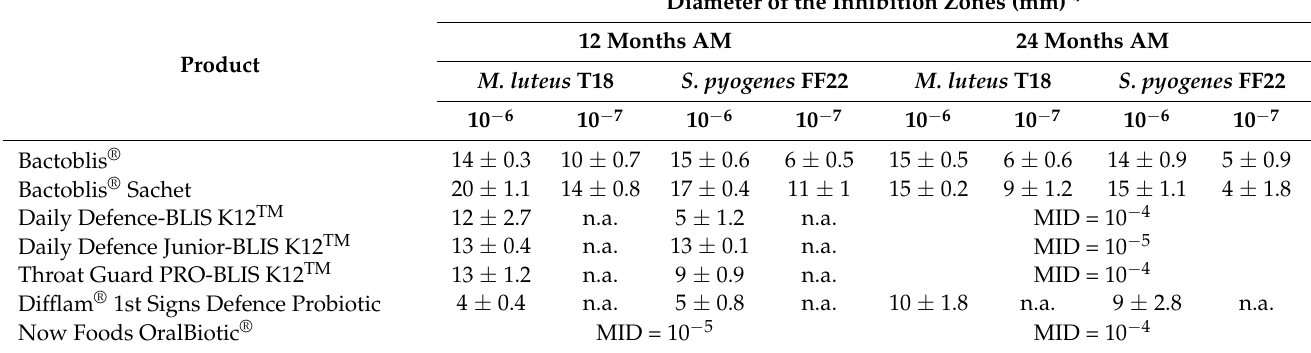
Table 4. Minimum inhibitory dilution (MID) of the commercial products and diameters of the inhibition zones they produced when tested against Micrococcus luteus T18 and Streptococcus pyogenes FF22 at 12 months and 24 months AM.